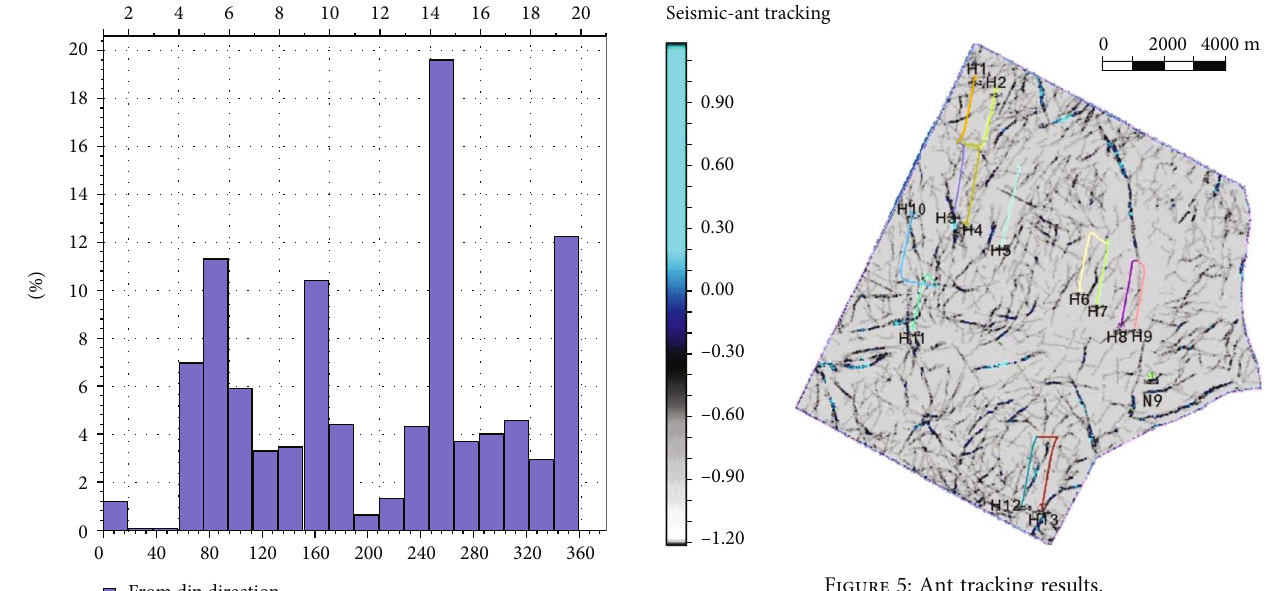
Figure 5: Ant tracking